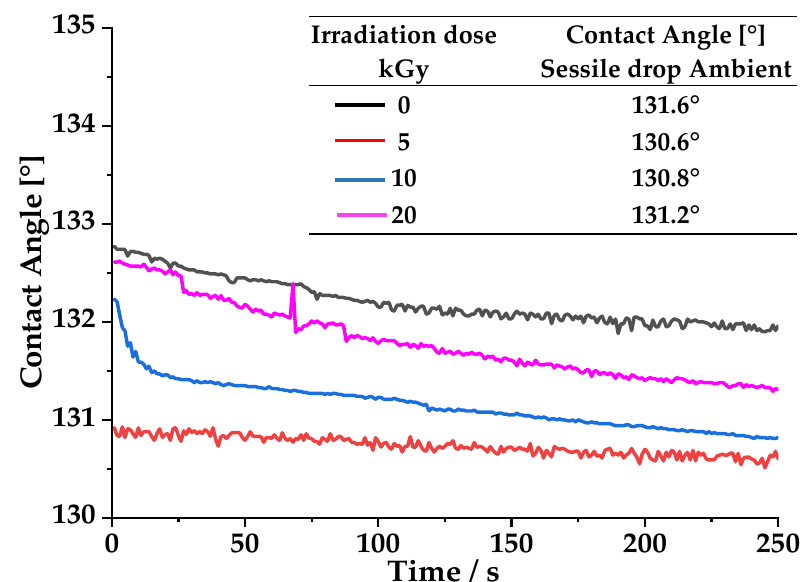
Figure 12. Contact angle by sessile drop without drying the sample (ambient), of the nonirradiated and irradiated TiO 2 . Insert, contact angle.